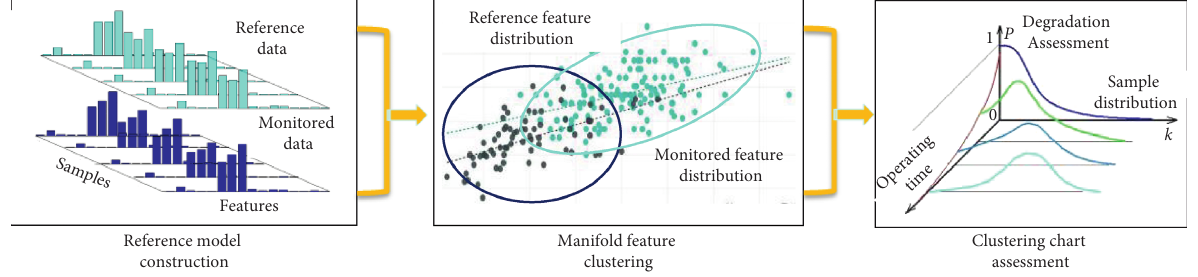
Figure 2: The illustration of feature clustering Table 1: Original features.